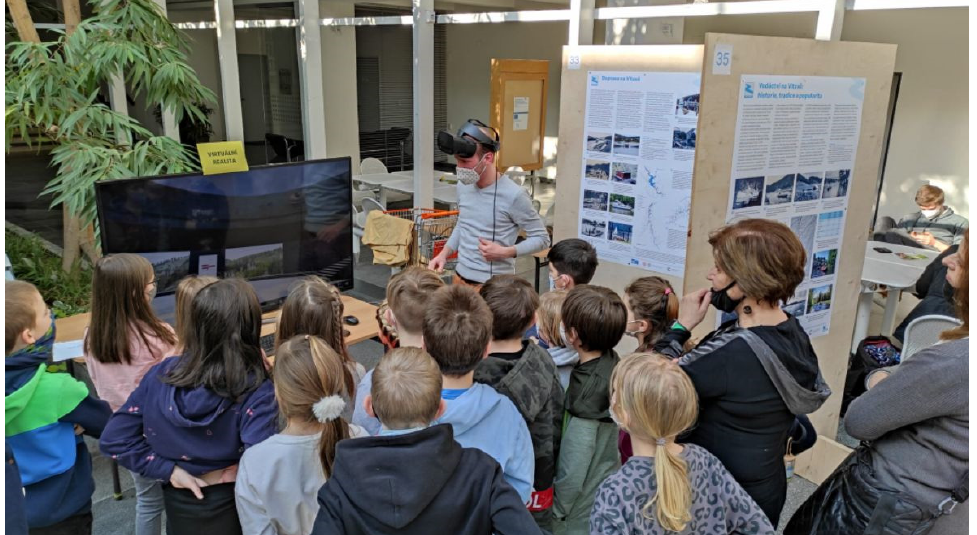
Figure 14. Co-author Vojt ě ch Cehák demonstrating virtual reality during a tour of a primary school at the exhibition Vltava—Transformations of the Historical Landscape .